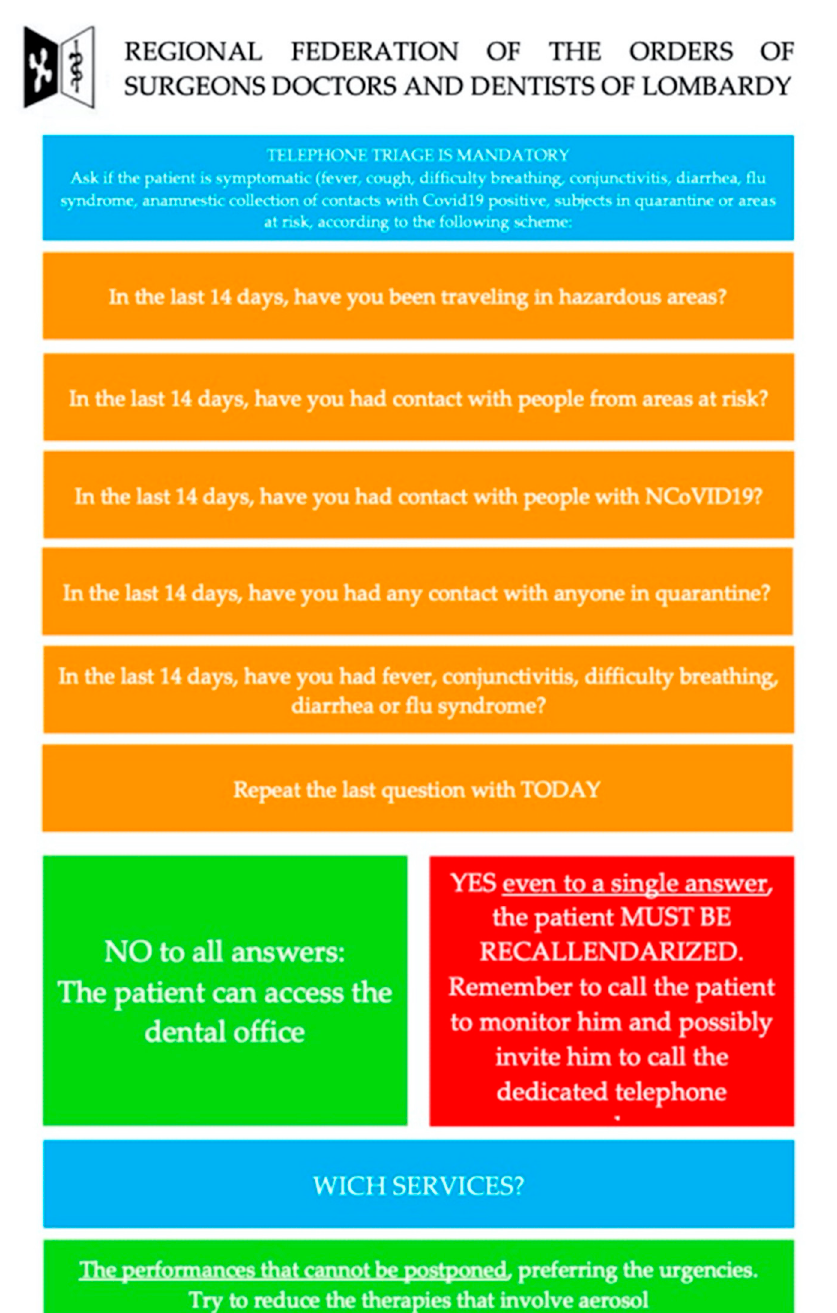
Figure 1. Telephone triage before entering the office.